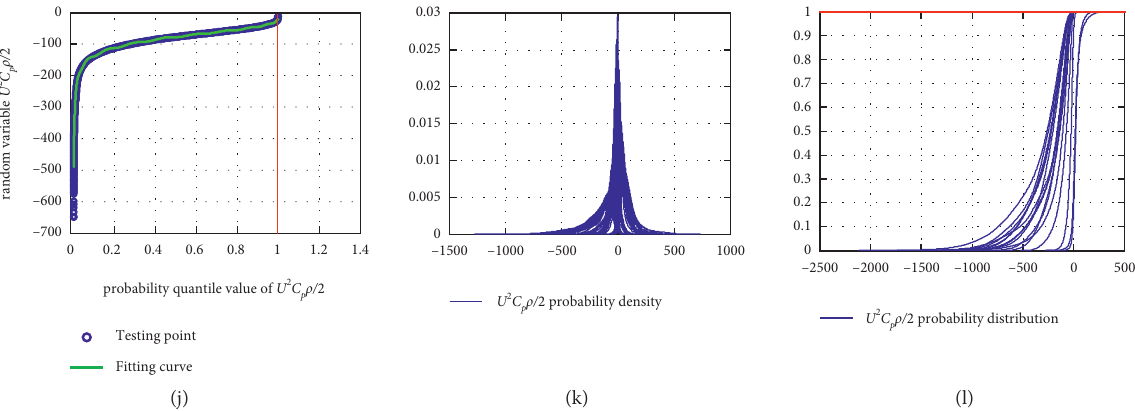
Figure 17: The probability density and probability distribution diagram of random variables in the intermediate process of the algorithm. (a) Probability density diagram of wind pressure coefficient C p time history of measuring point 41-1 at 0 ° wind direction. (b) Probability distribution diagram of wind pressure coefficient C p time history of measuring point 41-1 at 0 ° wind direction. (c) Probability density diagram of wind pressure coefficient U time history of measuring point 41-1. (d) Probability distribution diagram of wind pressure coefficient U time history of measuring point 41-1 at 0 ° wind direction. (e) Probability density diagram of U 2 time history of measuring point 41-1 at 0 ° wind direction. (f) Probability distribution diagram of U 2 time history of measuring point 41-1 at 0 ° wind direction. (g) Probability density diagram of U 2 C p time history of measuring point 41-1 at 0 ° wind direction. (h) Probability distribution diagram of U 2 C p time history of measuring point 41-1 at 0 ° wind direction. (i) 20-order polynomial fitting diagram of probability distribution of time history of measuring point 41-1 at 0 o wind direction. (j) 20-order polynomial fitting diagram of inverse function of probability distribution of time history of measuring point 41-1 at 0 ° wind direction. (k) Diagram of superimposed probability density curves of points in top 4 of maximum wind pressure coefficient series (64 curves). (l) Diagram of superimposed probability distribution curves of points in top 4 of maximum wind pressure coefficient series (64